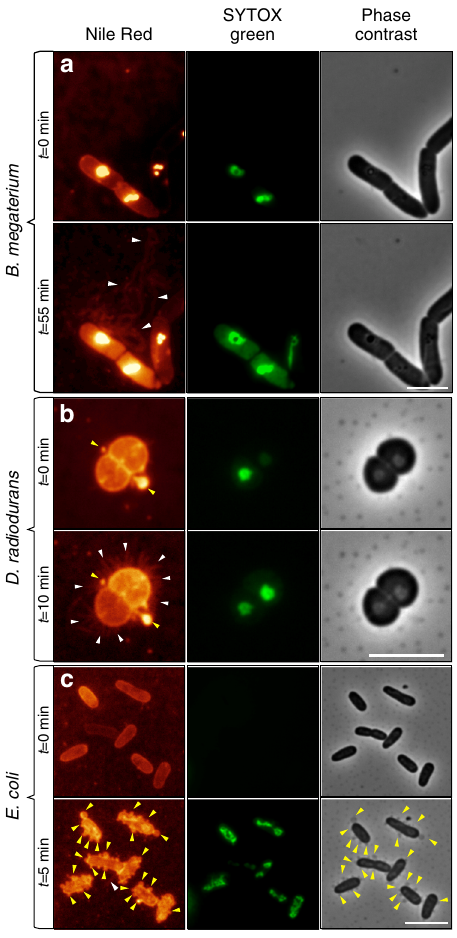
Fig. 5 Formation of NTs from selected bacterial species. a Bacillus megaterium (LK1780) was grown to exponential phase. The microscopic samples for this and other organisms shown in this Figure were prepared as in Fig. 3 (the P-GLG method). After 55min under the coverslip, the cells formed NTs that were similar to those of B. subtilis . b Exponentially growing cells from the extremophile bacterium Deinococcus radiodurans (LK1553). c Exponentially growing cells of gram-negative E. coli (LK1133). In all samples, membranes were stained with Nile Red (false colored glow) and SYTOX green (green); the third column shows phase-contrast images. All experiments were performed three times. Yellow arrows indicate membranous blebs and vesicles, white arrows indicate NTs. Scale bar = 5 μ